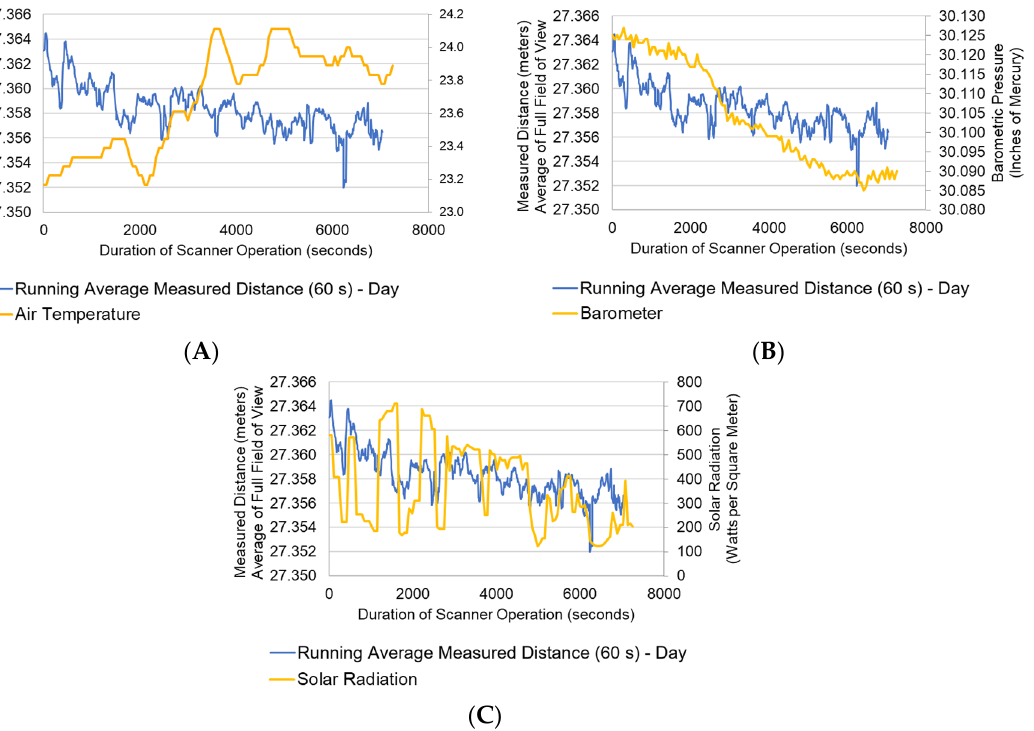
Figure 33. Livox ® Mid – 40 distance measurements (running average, per 60 s) and ongoing weather conditions ( A ) air temperature, ( B ) barometric pressure, and ( C ) solar radiation during day experiment.